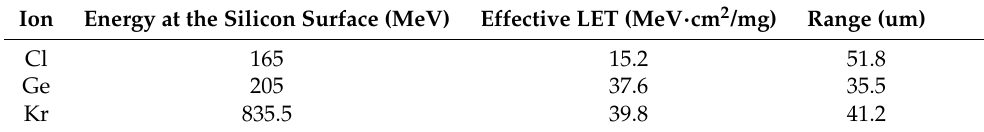
Figure 5. The detailed layout placement in the test chip. Table 2. Heavy ions used in the